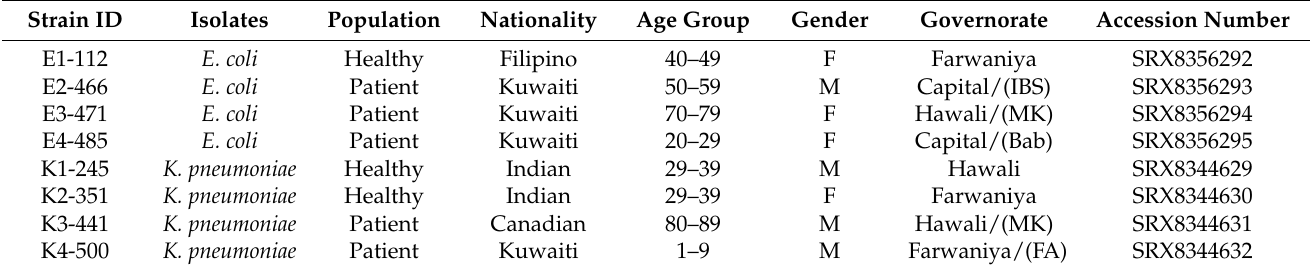
Table 1. Demographic data of Escherichia coli and Klebsiella pneumoniae isolates obtained from patients and healthy